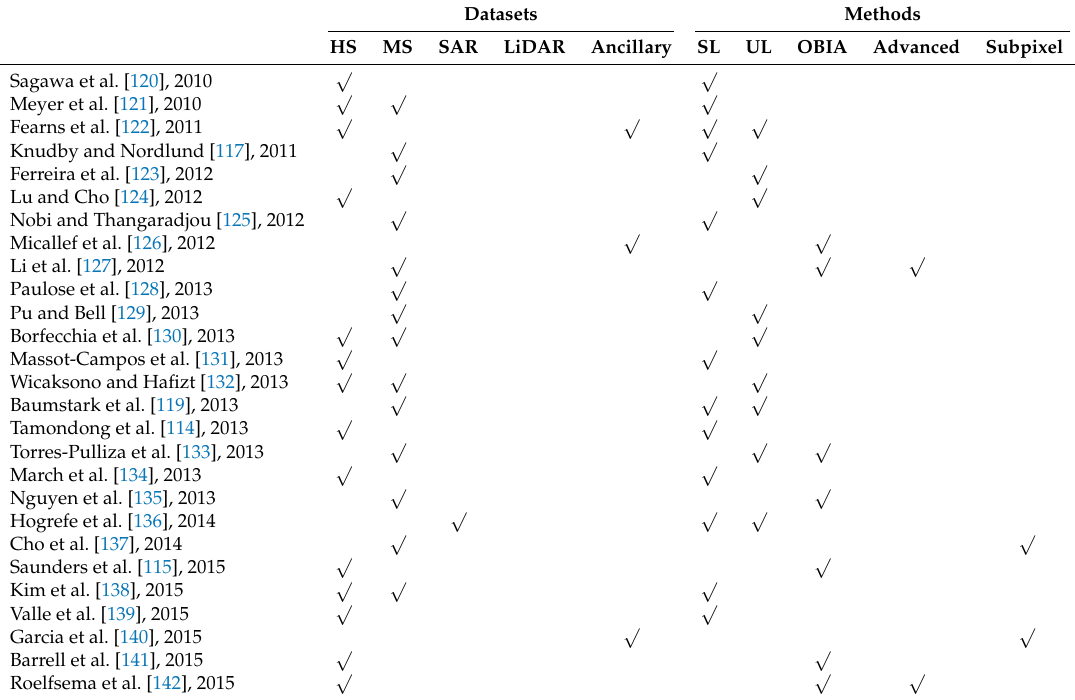
Table 4. Seagrass mapping techniques using remotely-sensed data from